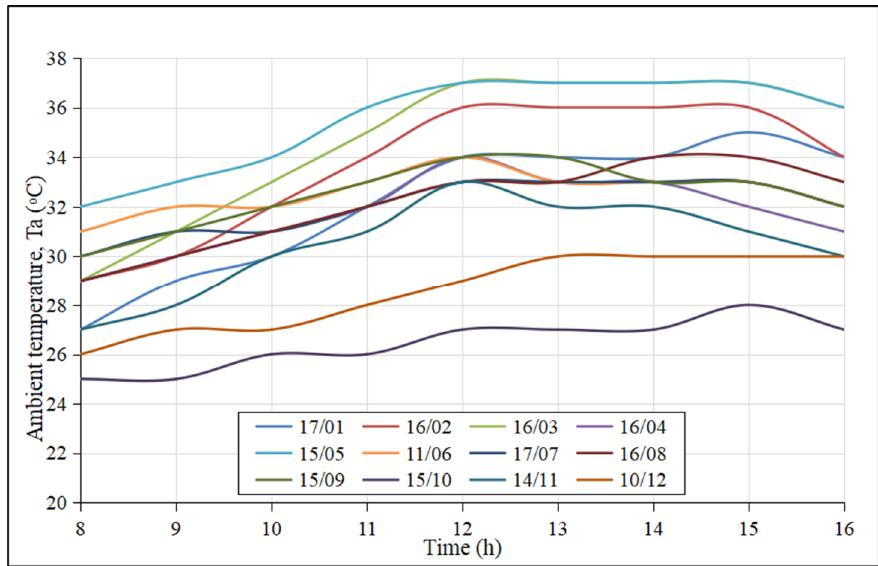
Figure 9. Ambient temperature of typical days of the year.